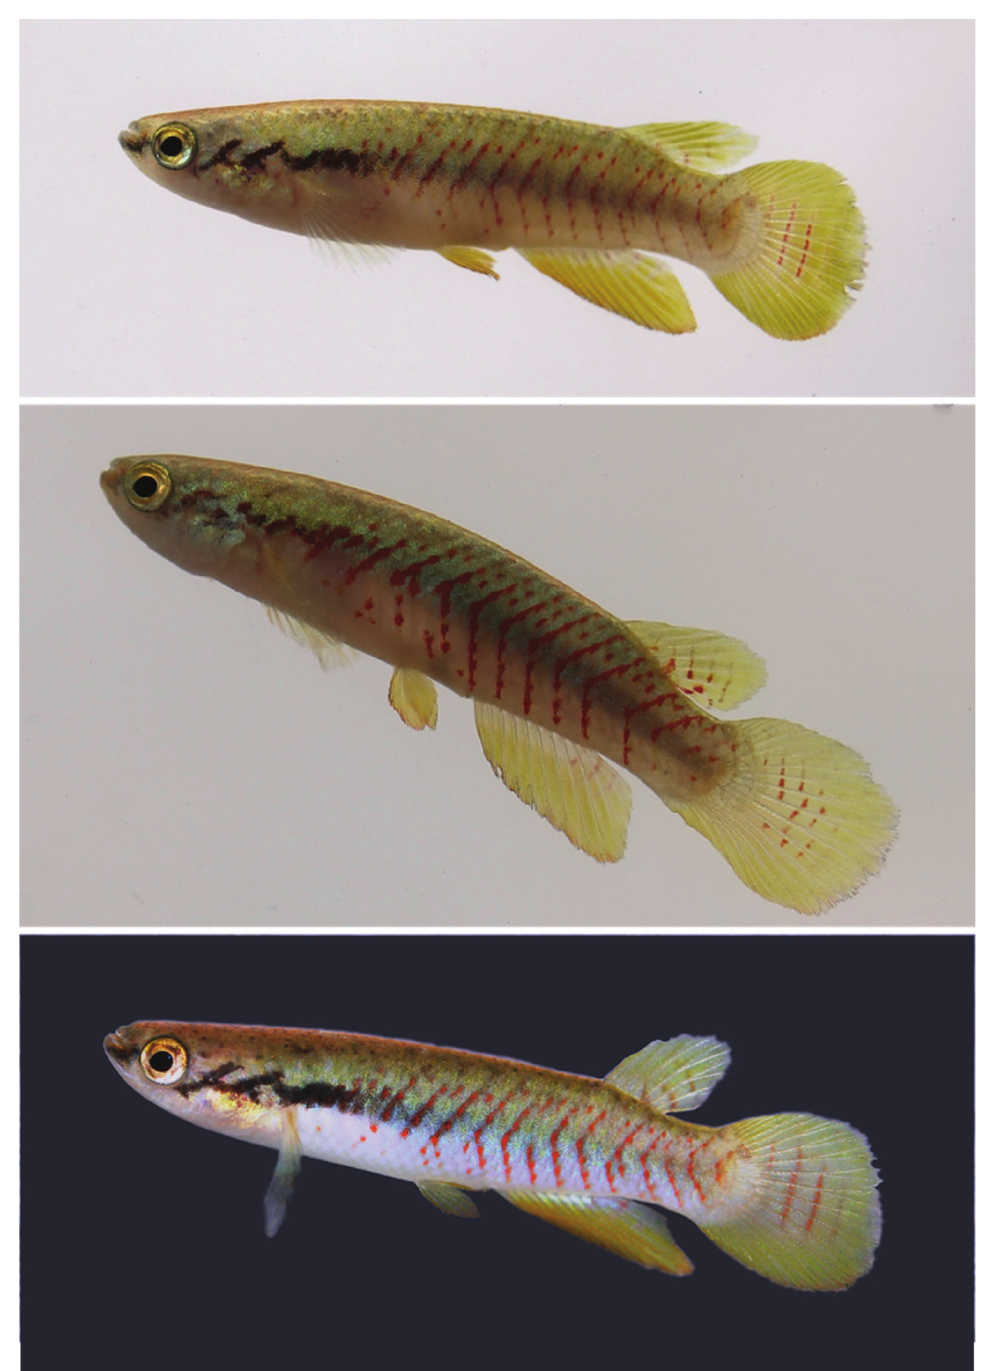
Figure 5. Colour pattern variation of male paratypes of M. ivinhemensis sp. n., MCP 53153, Nova Andradina municipality, Rio Ivinhema, Mato Grosso do Sul